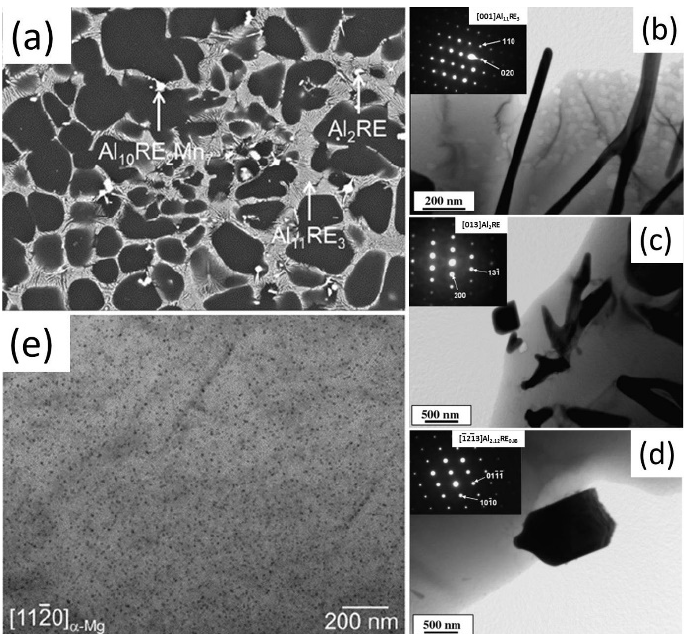
Figure 2. ( a ) Representative SEM image of traditional AE44 alloy, BF-TEM images, and/or SAED patterns of ( b – d ) intermetallic phases and ( e ) fine precipitates in the Mg matrix [50,106].